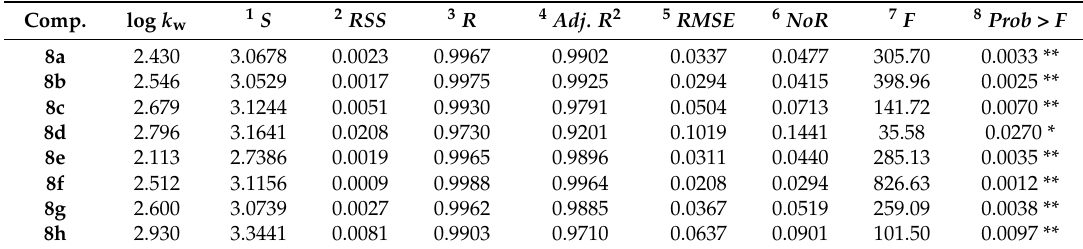
Table 2. Extrapolated log k w values (RP-HPLC) of the analyzed molecules 8a – h and statistical descriptors ( RSS , R , Adj. R 2 , RMSE , NoR , F and Prob > F ), which characterized a linear relationship